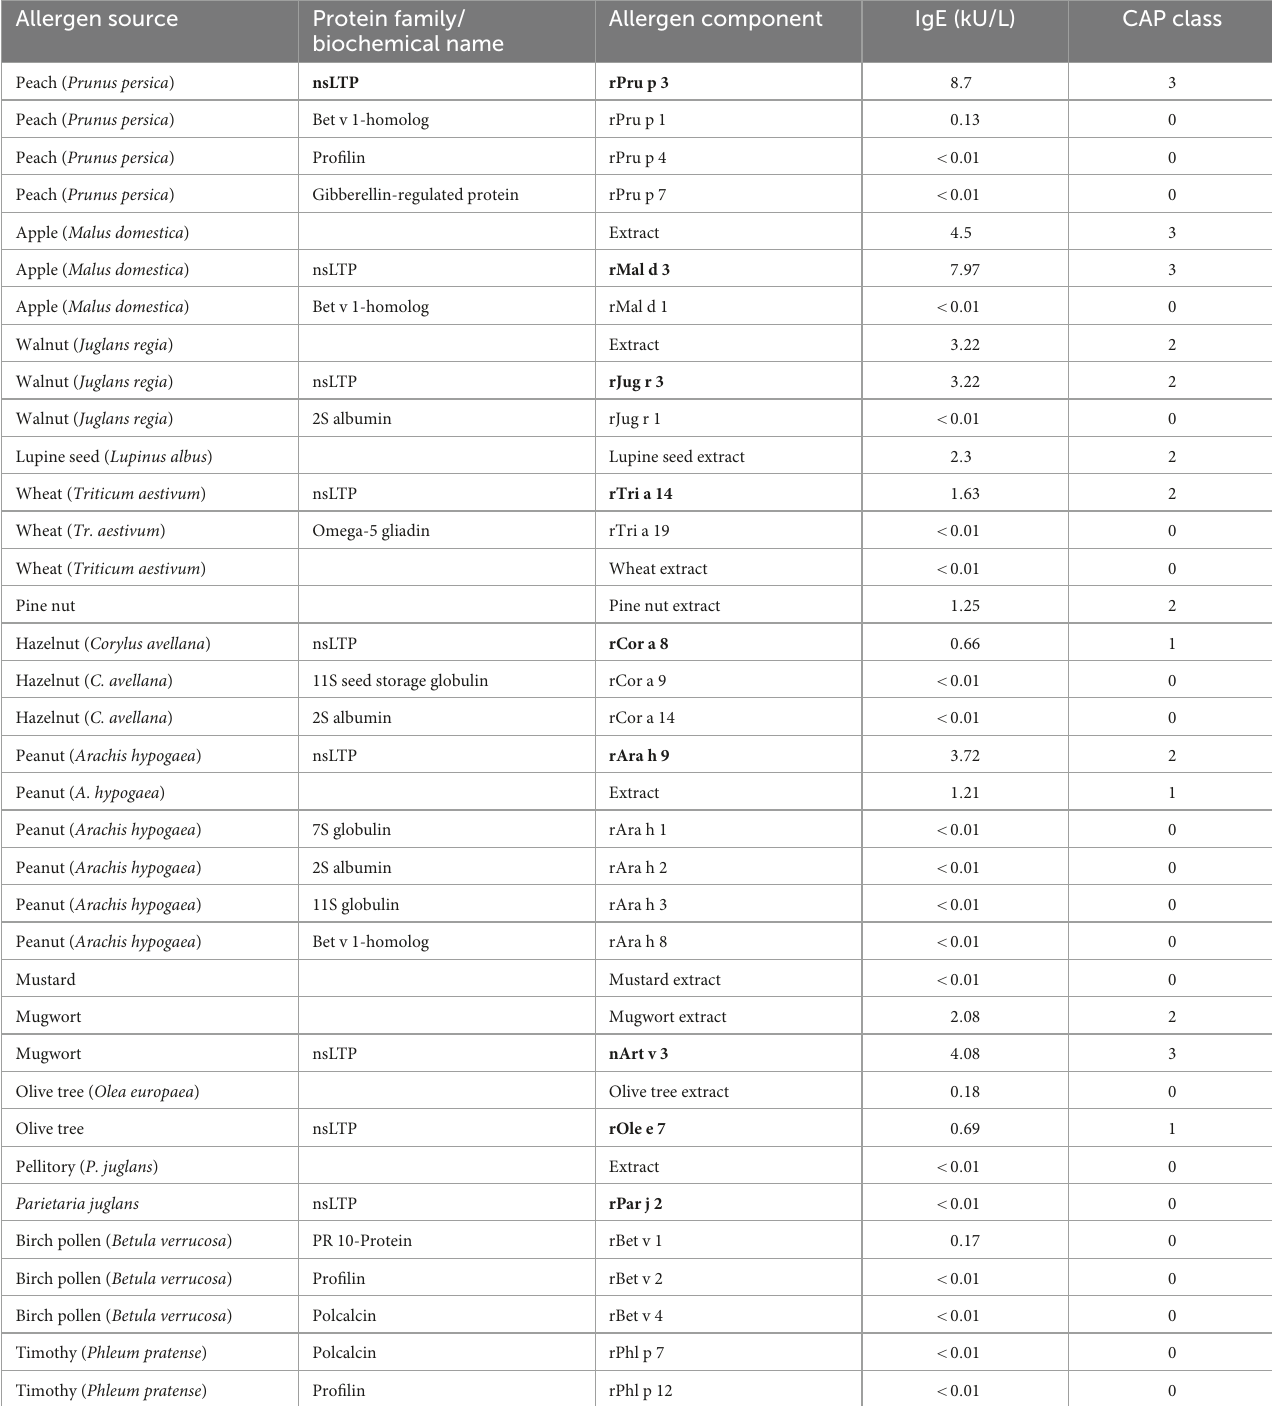
TABLE 1 In vitro allergy diagnostics: Specific IgE-antibody detection results